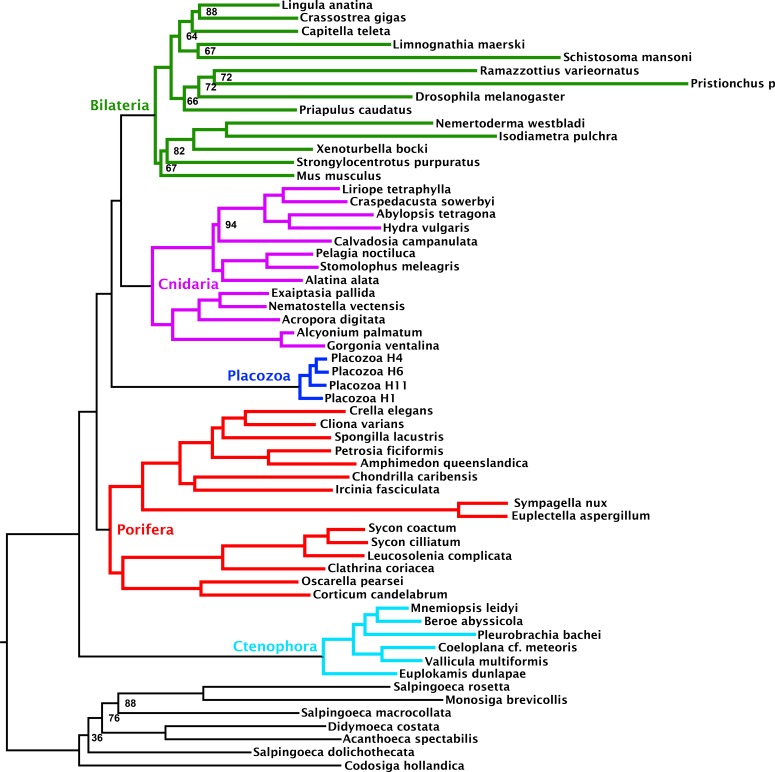
Maximum likelihood tree under a profile mixture model inferred from the 349-orthologue matrix composed from the subset of genes binned as failing the null-simulation compositional bias test.Nodes annotated with ultrafast bootstrap supports with NNI correction; unannotated nodes received full support.